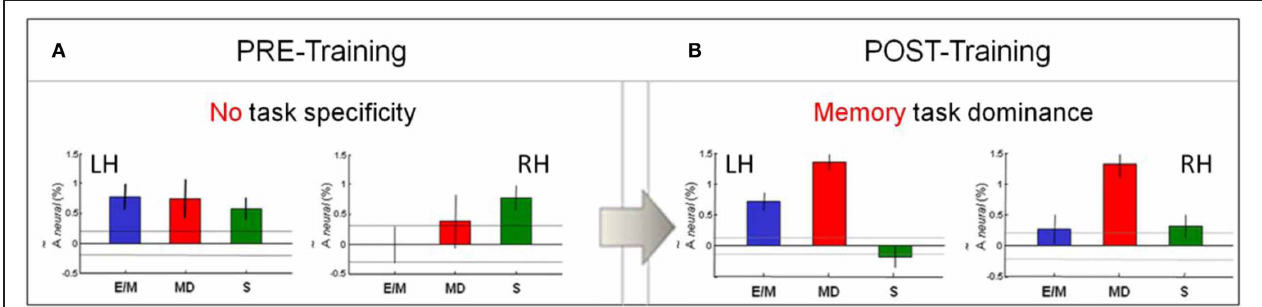
activation levels. The dashed lines represent the 99% “ zero ” confidence interval , within which the activations are not significantly different from zero. The error bars are 99% “ difference ” confidence intervals designed to illustrate the t -test to assess the significance of the differences between activation levels in each figure, i.e., the amplitude differences are not significant unless they exceed the confidence intervals for both compared activations.